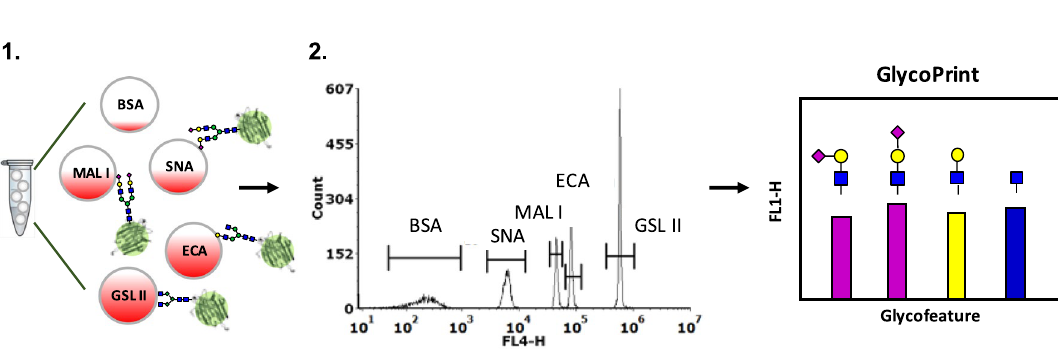
Figure 1. A hypothetical GlycoPrint from an ensemble of 7 typical N -linked glycans with unique glycosylation elements grouped by color and monosaccharides shown in SNFG notation 51 . The choice of detection element (lectin, antibody, or other carbohydrate-specific reagent) determines whether the glycofeature will comprise a single monosaccharide or larger oligosaccharide. A GlycoPrint is a representation of the aggregate signal for each glycofeature.